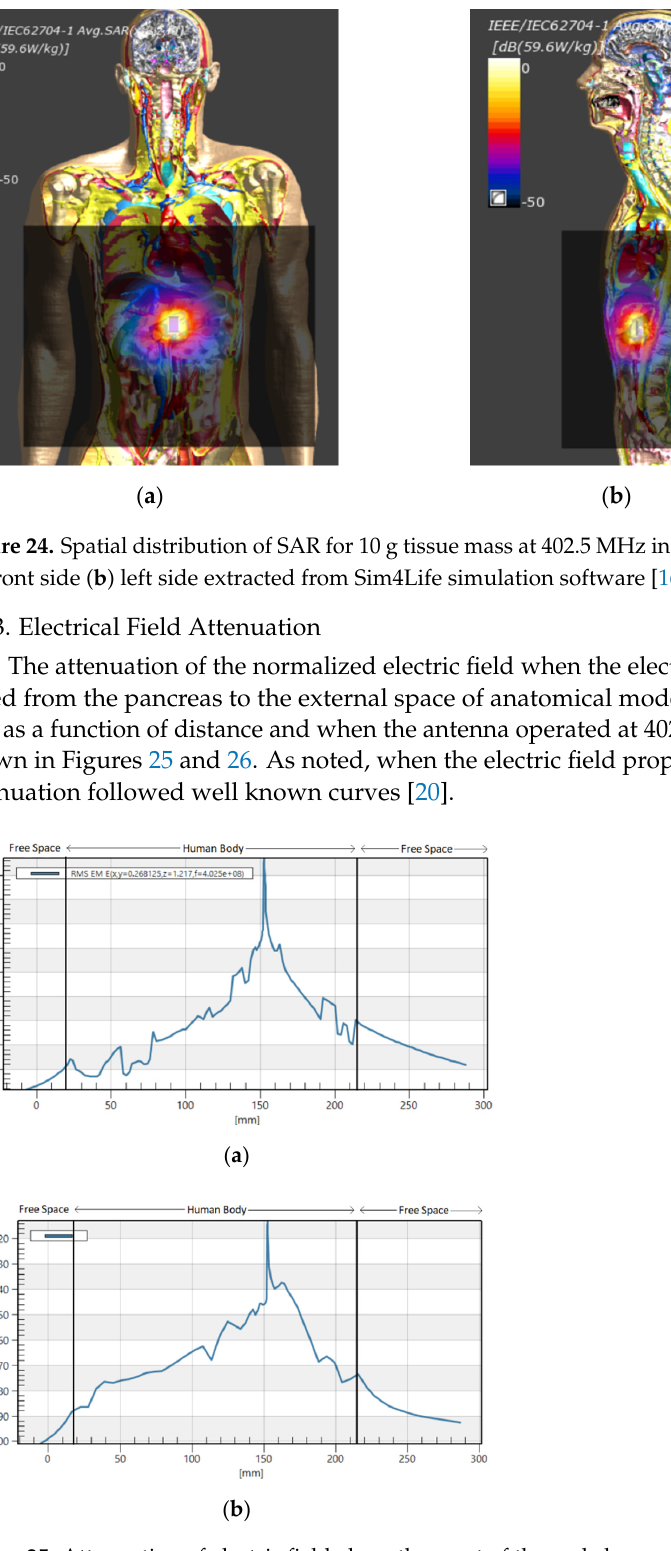
Table 4. Specific absorption rate and maximum permissible input power.